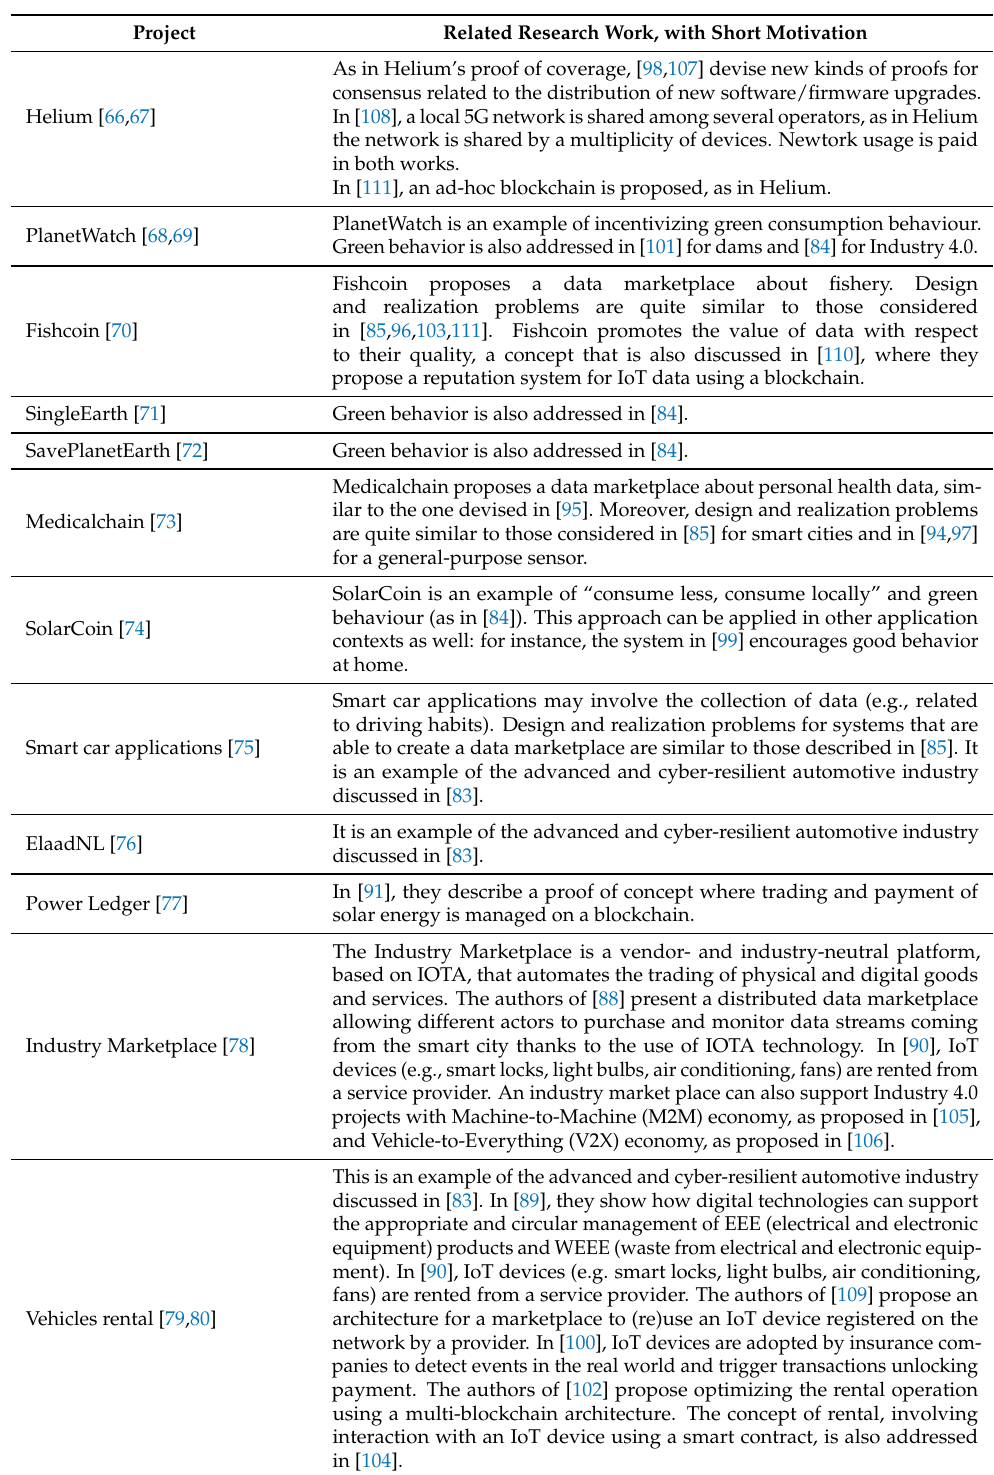
Table 5. Projects and related scientific papers identified by the PRISMA